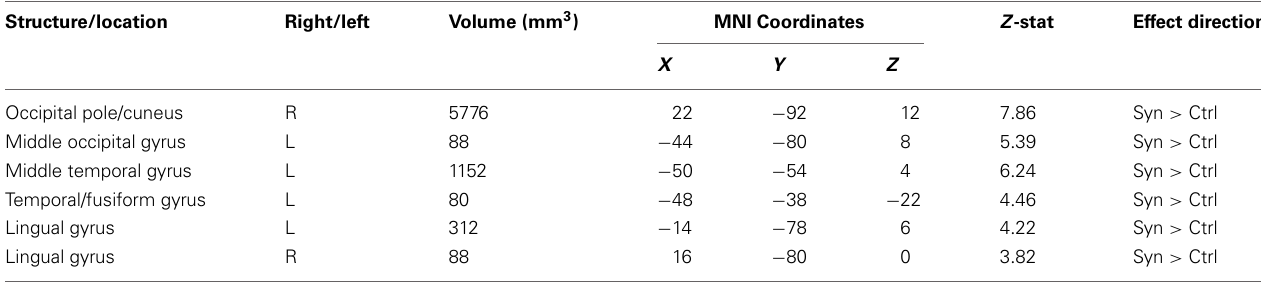
Table 2 | White matter volume difference (whole brain VBM analysis).